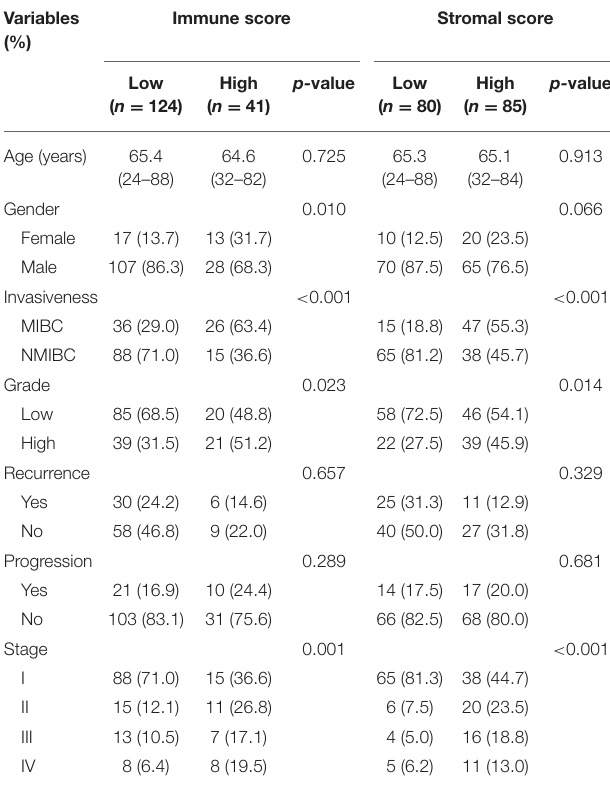
TABLE 1 | Clinicopathologic characteristics of patients in different immune/stromal score groups. Variables